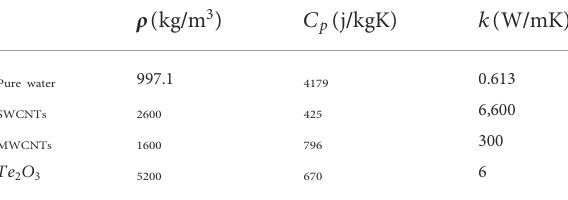
TABLE 1 Thermo-physical properties of water, CNTs , and Te 2 O 3 nanoparticles.